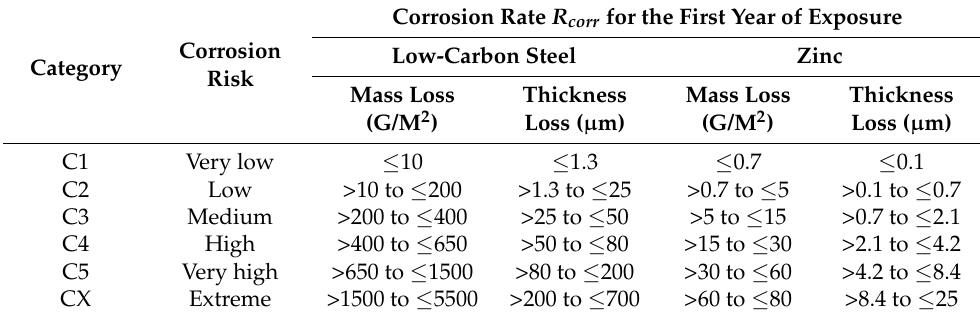
Table 1. The corrosion rate of steel and zinc with respect to corrosivity categories (EN ISO 9223) [4]. Corrosion Rate R corr for the First Year of Exposure Corrosion Low-Carbon Steel Zinc Category Risk Mass Loss Thickness Mass Loss Thickness (G/M 2 ) Loss ( µ m) (G/M 2 ) Loss ( µ m) C1 Very low ≤ 10 ≤ 1.3 ≤ 0.7 ≤ 0.1 C2 Low >10 to ≤ 200 >1.3 to ≤ 25 >0.7 to ≤ 5 >0.1 to ≤ 0.7 C3 Medium >200 to ≤ 400 >25 to ≤ 50 >5 to ≤ 15 >0.7 to ≤ 2.1 C4 High >400 to ≤ 650 >50 to ≤ 80 >15 to ≤ 30 >2.1 to ≤ 4.2 C5 Very high >650 to ≤ 1500 >80 to ≤ 200 >30 to ≤ 60 >4.2 to ≤ 8.4 CX Extreme >1500 to ≤ 5500 >200 to ≤ 700 >60 to ≤ 80 >8.4 to ≤